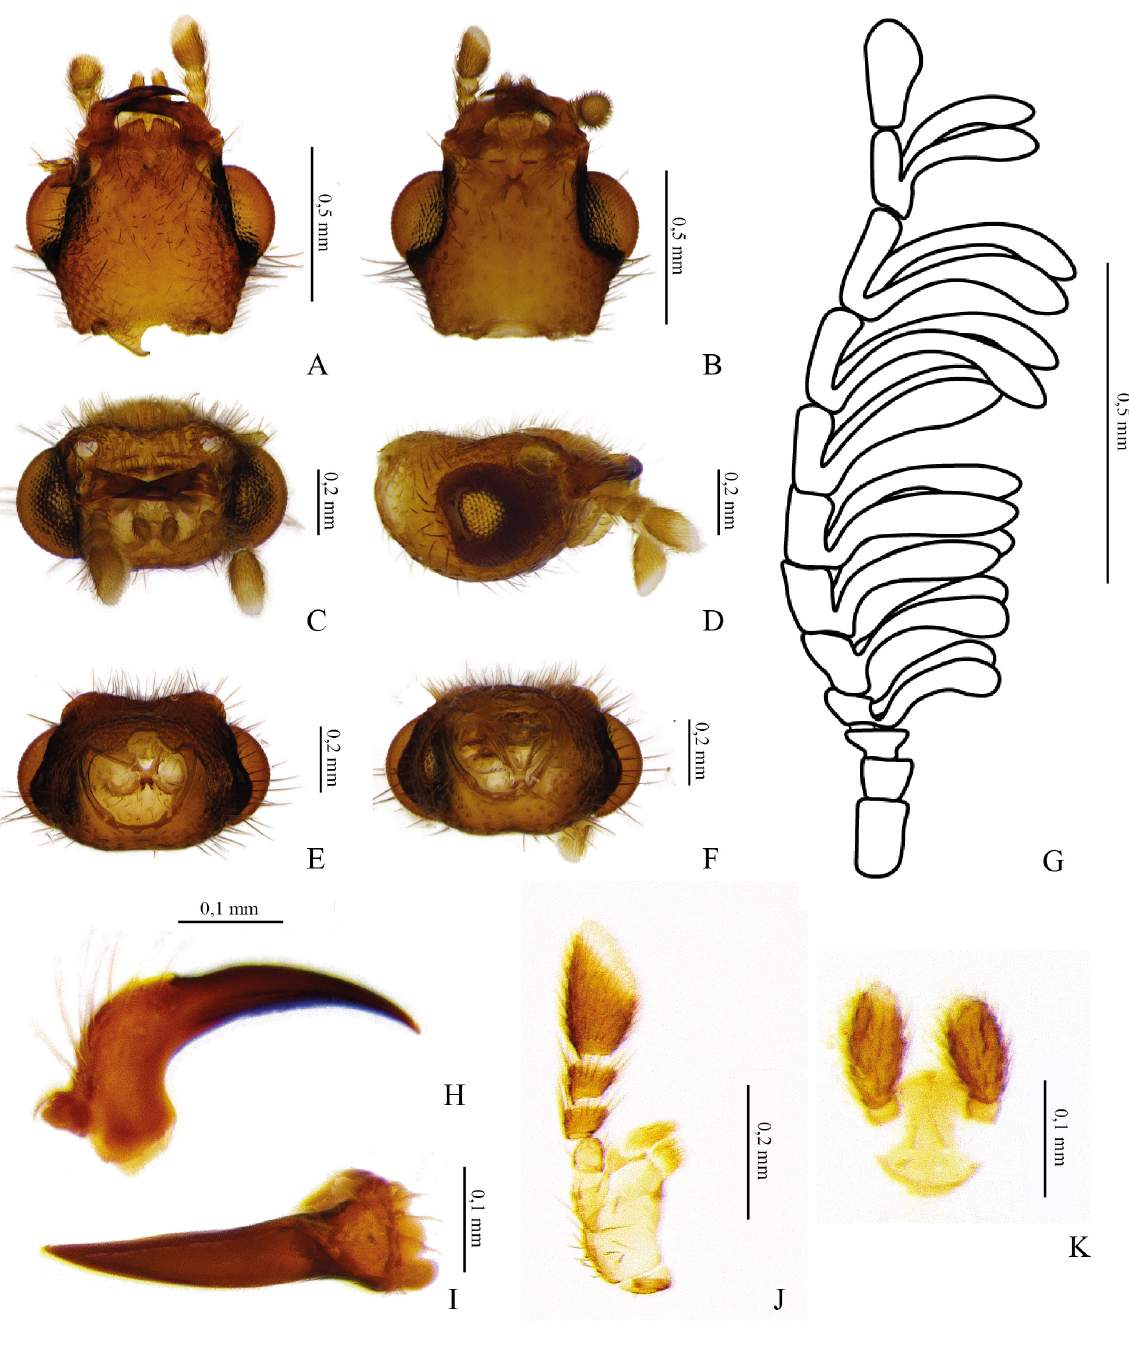
Fig. 2. Iviephengus ferreirai gen. et sp. nov., paratype, ♂ (DZRJ). A . Head, dorsal. B . Head, ventral. C . Head, frontal. D . Head, lateral. E . Head, posterior. F . Head, occipital. G . Antenna, lateral. H . Left mandible, dorsal. I . Left mandible, frontal. J . Maxilla, ventral. K . Labium,